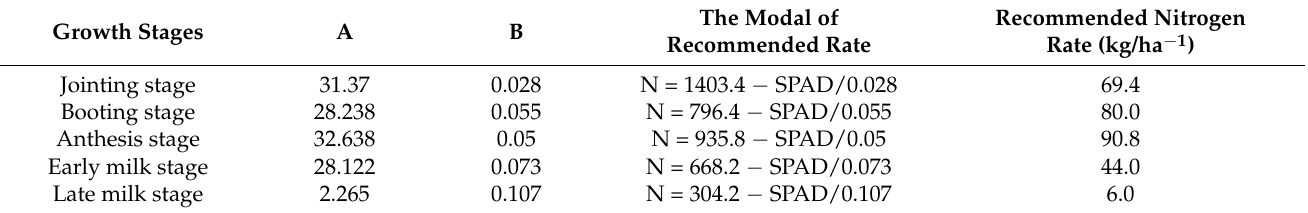
Figure 6. The relationship between nitrogen application levels and grain yield. Red numbers represent the theoretical maximum grain yield in 2021 and 2022, which were 8083 and 8309 kg ha − 1 , respectively. ** indicates significant difference at the 0.01 level. Black numbers represent the nitrogen application level corresponding to the theoretical maximum grain yield in 2021 and 2022, which were 282 and 283 kg ha − 1 , respectively. Blue arrow represents the function that has higher correlation coefficient (r 2 ) between nitrogen application levels and grain yield in different years. Table 2. Nitrogen application recommendation model as per wheat growth stage based on critical SPAD values under TR6S (a new drip-irrigated system for spring